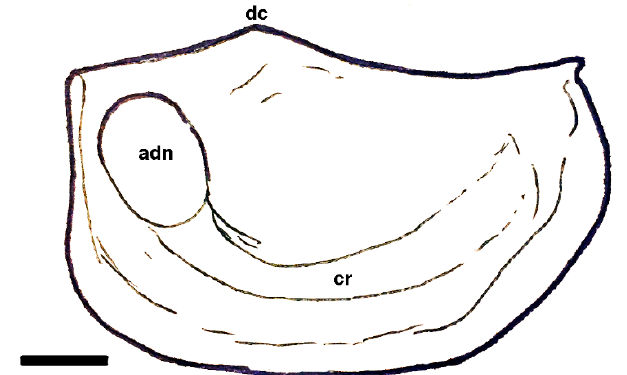
Figure 10. Cambria melnikovi . Anterior to left. Scale bar 1 mm. Abbreviations: adn , anterodorsal node; cr , connecting ridge; dc , dorsal cusp. Image Credit: Mark McMenamin.